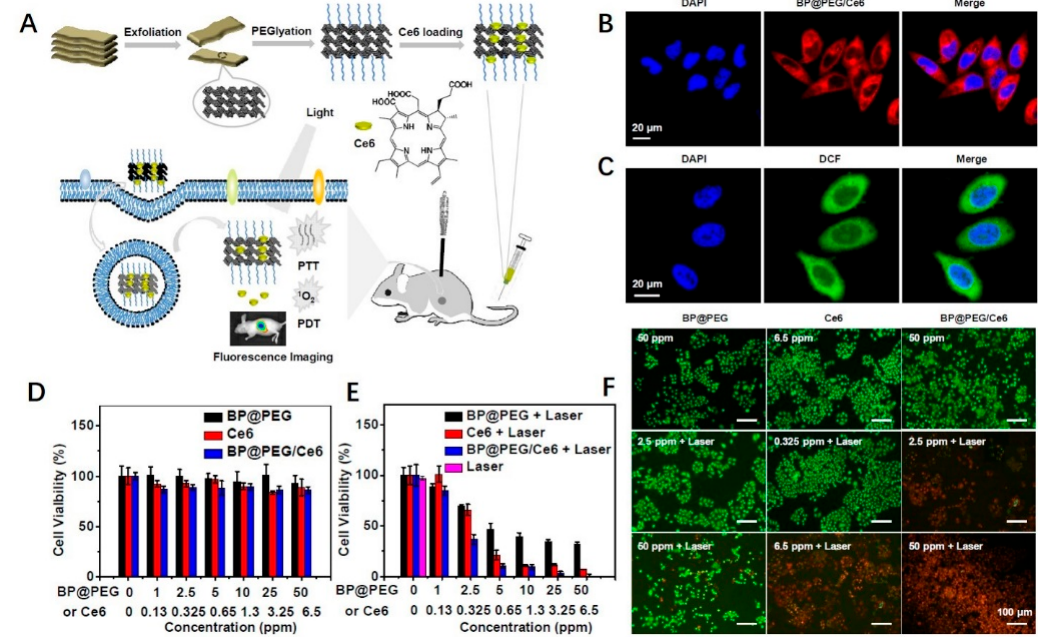
Figure 4. ( A ) Schematic representation of BP@PEG/Ce6 NSs preparation and its application as fluo- rescence and thermal imaging guided photothermal and photodynamic cancer therapy; ( B )